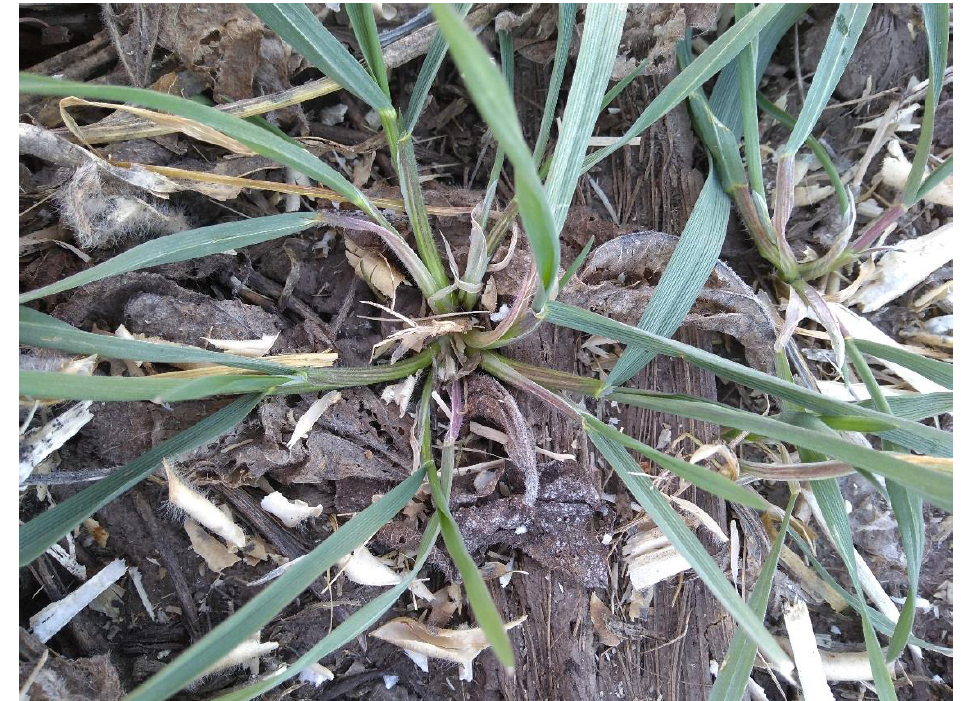
Figure 4. Rye at Mead 70 days after broadcasting into soybean. Rye was seeded 21 September; picture was taken 30 November 2017. Note many tillers, short internodes, and dark-green color.